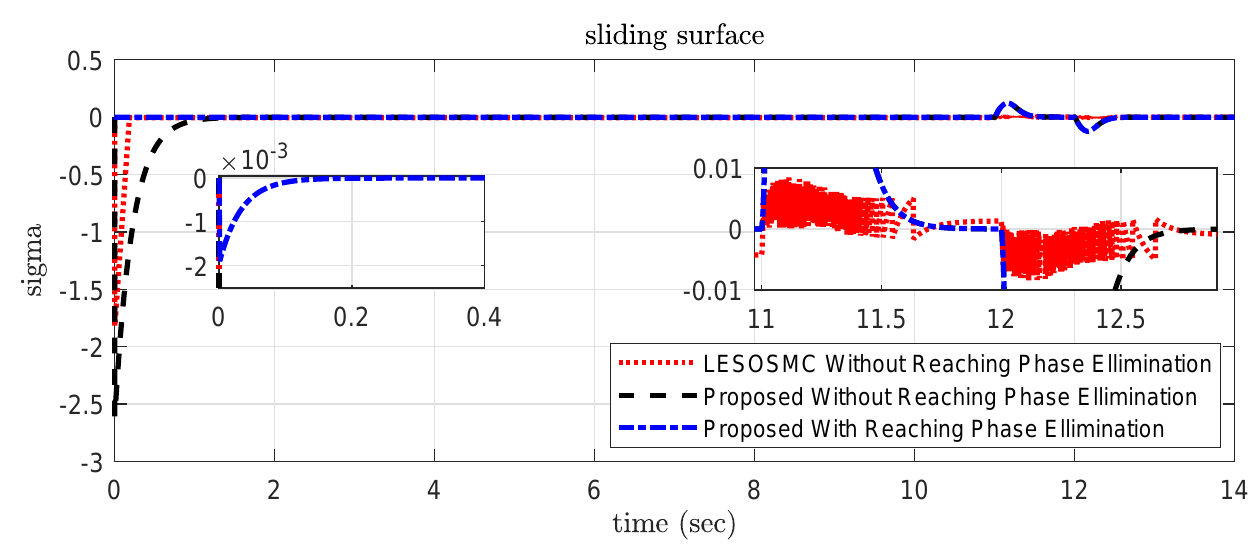
Figure 12. Simulation result of sliding surface σ .